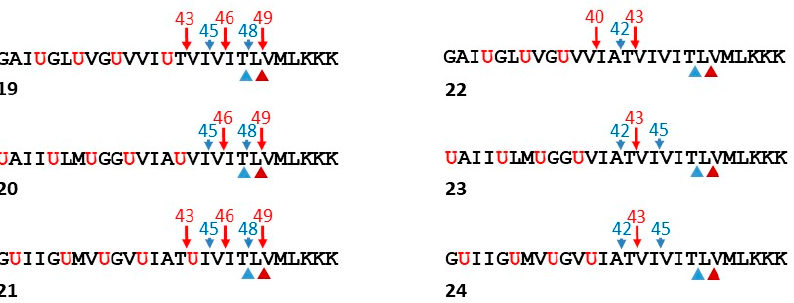
Figure 8. Functional probes for γ -secretase. Peptides based on the TMD of APP were designed with helix-inducing α -aminoisobutyric acid (Aib) installed in the N-terminal region. Proteolytic products were detected by LC-MS. Endoproteolytic ( ε ) sites, indicated by the arrowheads below the peptide sequence, were determined by analysis of AICD-like products. Trimming sites, indicated by the arrows above the peptide sequence, were determined by analysis of A β -like products. Note that replacement of the most C-terminal Aib in peptides 19 – 21 with the corresponding APP TMD residue (peptides 22 – 24 ) leads to most effective trimming, producing shorter A β -like prod- ucts.